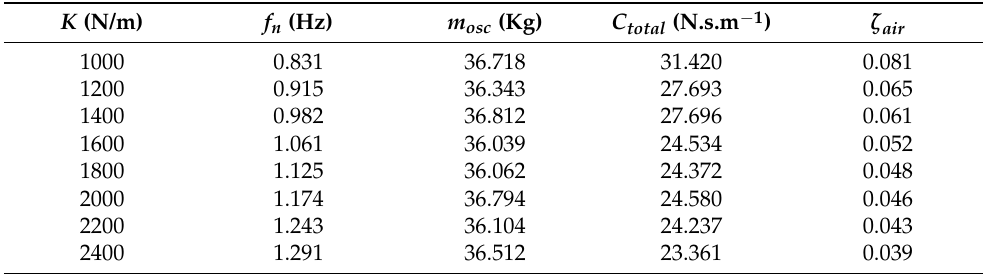
Table 1. The results of free decay test (I).